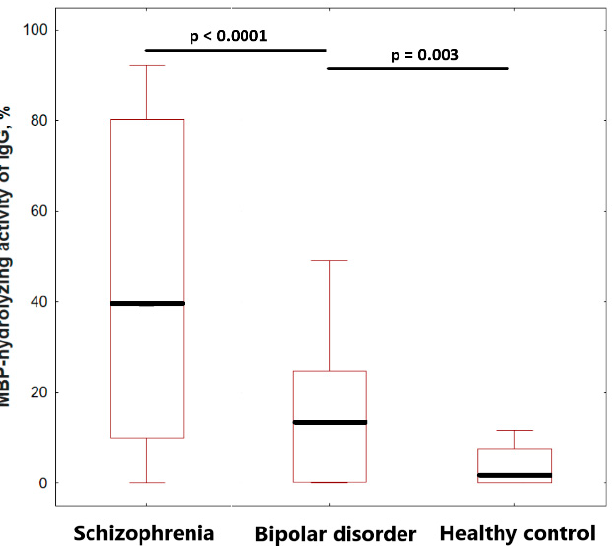
Figure 7. The MBP-hydrolyzing activity of IgGs from the sera of patients with bipolar disorder, schizophrenia and healthy peoples. The level of MBP-hydrolyzing activity of IgGs was normalized to standard conditions (1 mg/mL MBP proteins; 0.2 mg/mL IgGs; 20 h of incubation at 37 °C). The complete hydrolysis of the MBP as substrate is taken as 100%. The significance of the differences ( p ) is calculated by the Mann–Whitney U test.